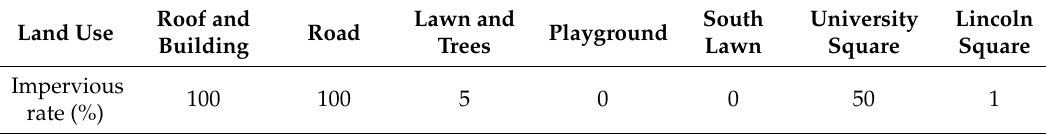
Table 3. The impervious rates of di ff erent land use in the study area. Land